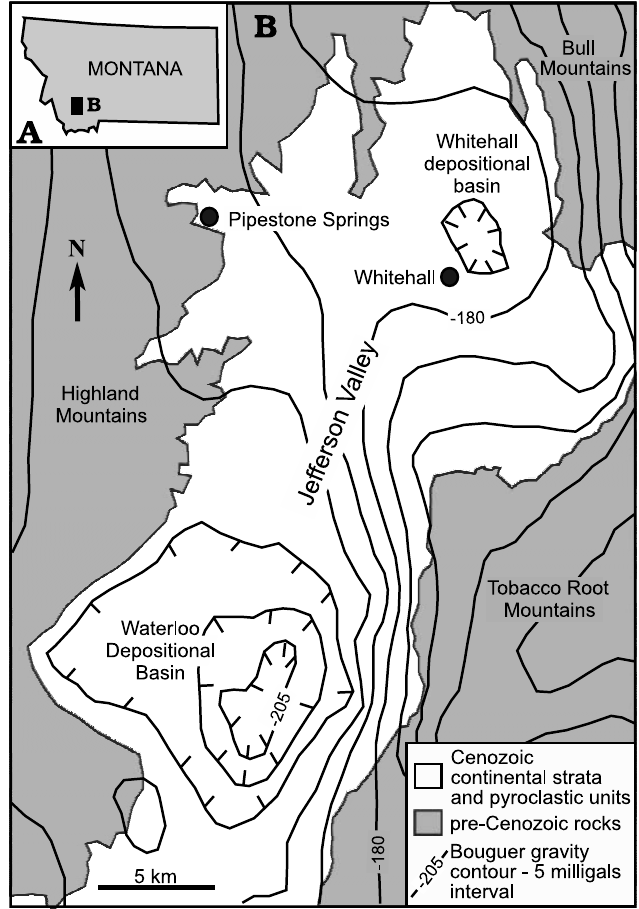
Fig. 2. Bouguer gravity map of the Jefferson Valley and surrounding area, southwest Montana. A . The state of Montana with the black rectangle showing location of the Jefferson River Valley. B . Bouguer gravity map of the Jefferson River Valley showing both the Whitehall and Waterloo depositional basins. Gravity contour interval of 5 milligals (modified from Hanneman 1989; Hanneman and Wideman 1991; data archived in McCafferty et al. 1998). Note that Pipestone Springs lies in a basin-margin position on the northwestern edge of the Jefferson